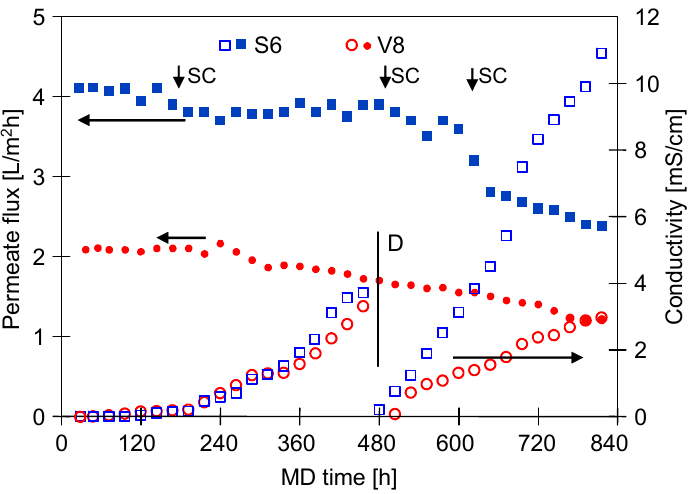
Figure 11. Changes in the permeate flux and distillate conductivity during continuous feed separation. Feed: NaCl solution (300 g/L) + oil (112–139 mg/L) + SDS (2 mg/L). Modules: SMD ‐ S6 ‐ 2 and SMD ‐ V8 ‐ 1. SC—temporary salt crystallization on the membrane surface; D—distillate tank filled with fresh distilled water.